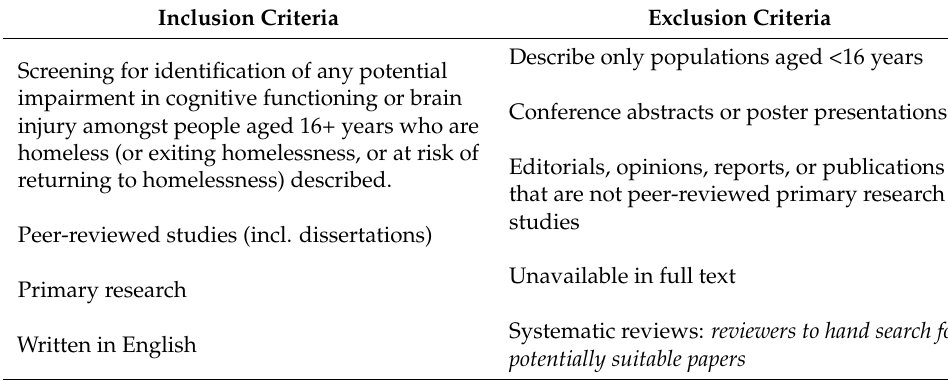
Table 1. Inclusion and exclusion